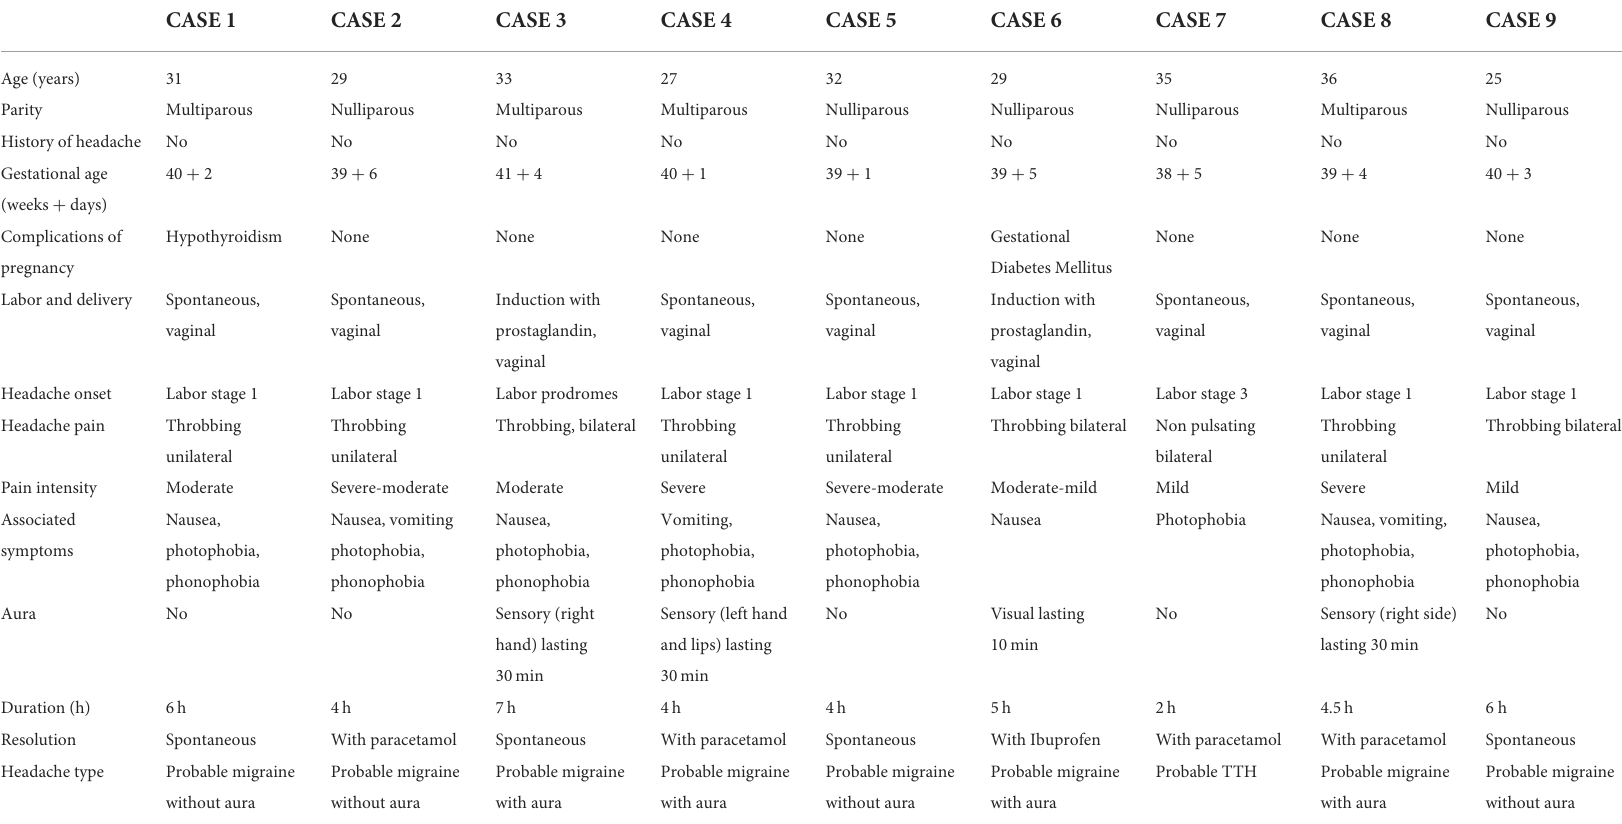
TABLE 4 Patient characteristics and headache features during labor, delivery, and